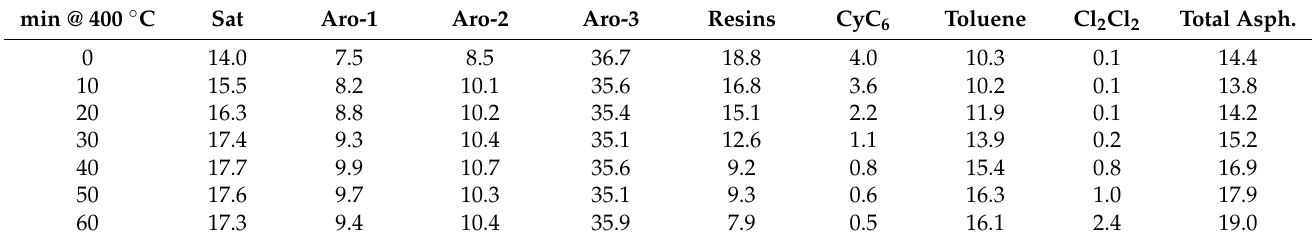
Table 6. SAR-AD data after 400 ◦ C pyrolysis of Lloydminster vacuum residue at increasing resi- dence